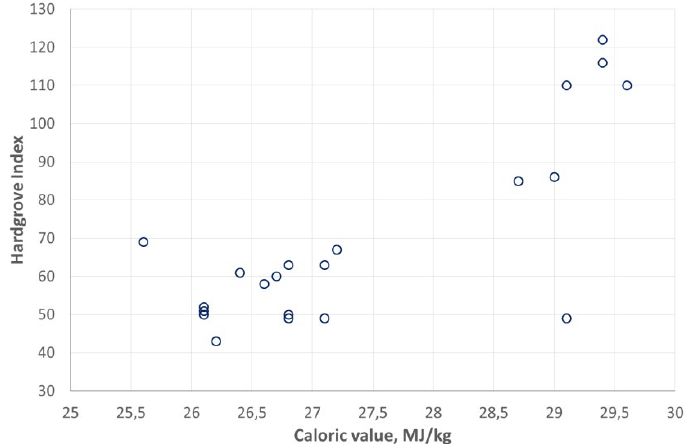
Figure 7. Hardgrove index values versus caloric values of tested coals.